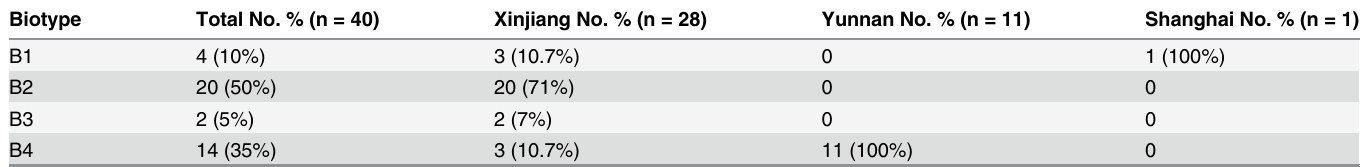
Table 3. Biochemical patterns of S . flexneri serotype 1b strains.